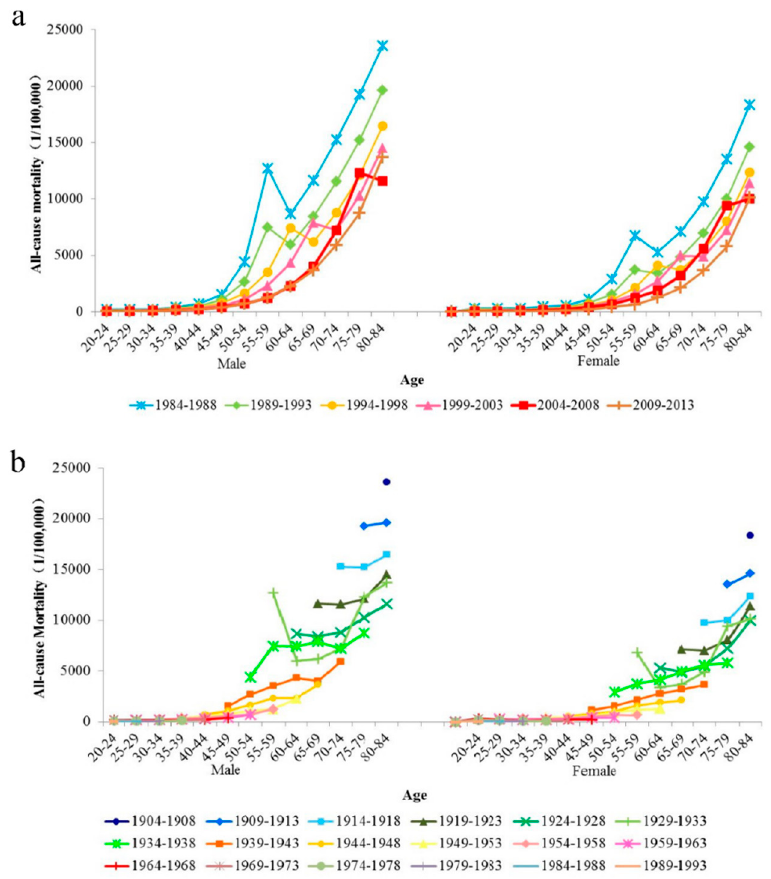
Figure 1. Age-specific all-cause mortality rates of Macheng City residents, male and female, 1984–2013. ( a ) The age-specific all-cause mortality by period. ( b ) The age-specific all-cause mortality by birth cohort.